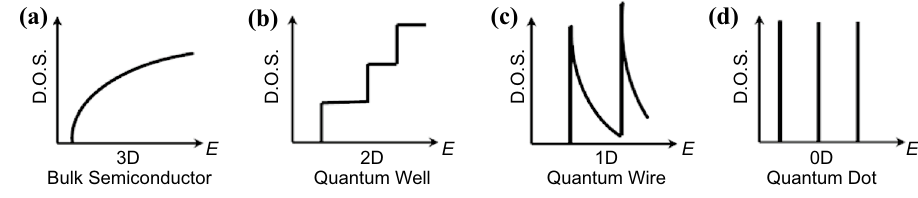
Fig. 2 Illustrations showing the electronic density-of-states of bulk and low dimensional materials. a Bulk semiconductor. b 2D materials. c 1-D materials (i.e., nanowires (NWs), nanorods). d Quantum dots. Adapted with permission from Ref.